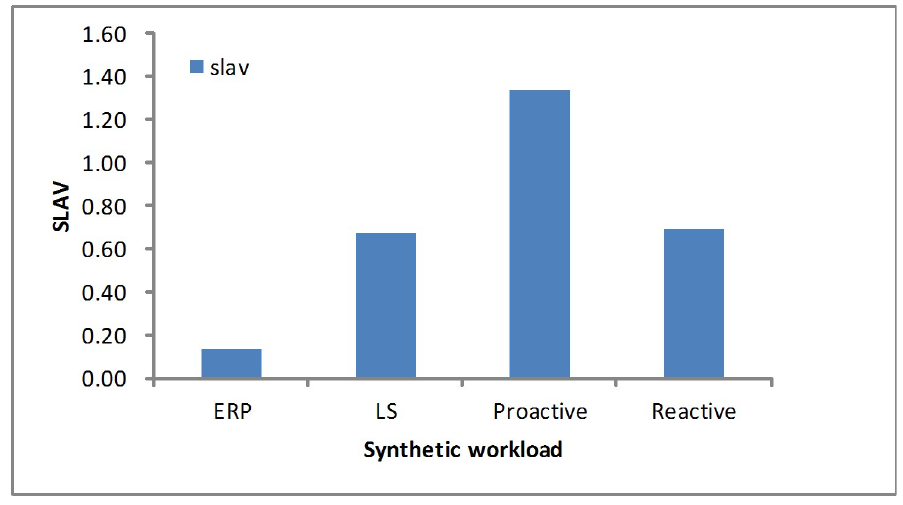
Fig 16. SLAV in the synthetic